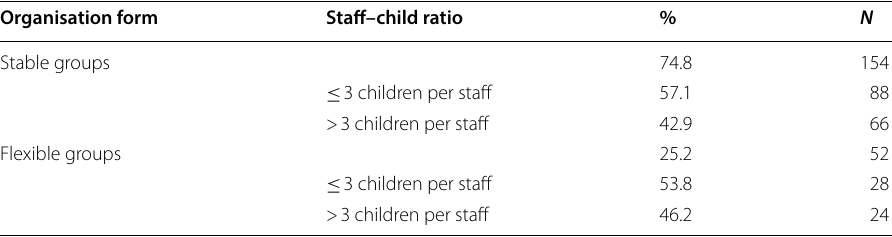
Table 1 Descriptive statistics for structural-quality